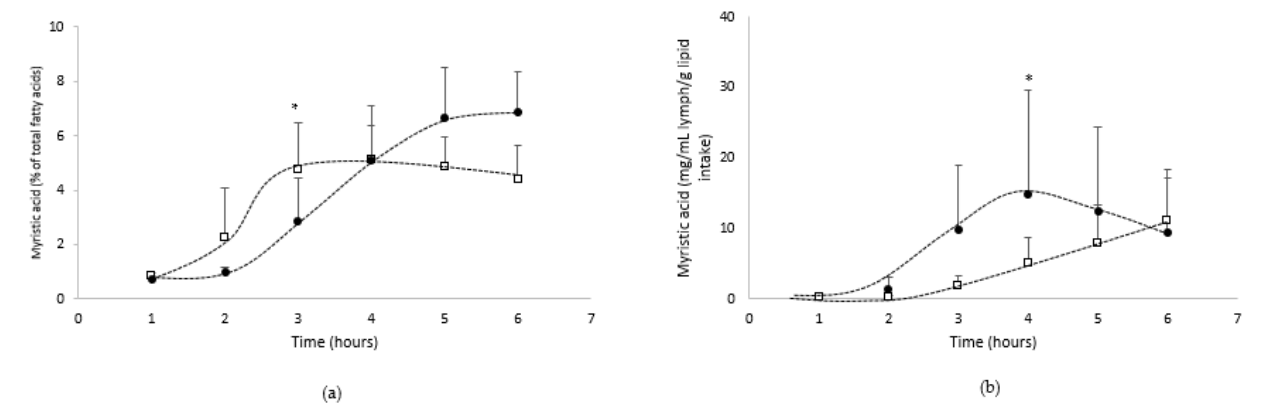
Figure 6. Kinetics of intestinal absorption of myristic acid (( a ): % of total fatty acids and ( b ): mg/mL lymph/g of lipid intake), in rats submitted to a lymphatic duct’s fistula ( n = 8 rats/group) and orally supplied with 200 mg of lipids from an oil either in bulk phase ( (cid:0) ) or emulsified with gum acacia ( • ) over a 6 h period. Data are presented as their means ± standard deviation *. For the same time period, data are significantly different between the two groups ( p < 0.05; Student’s t -test).